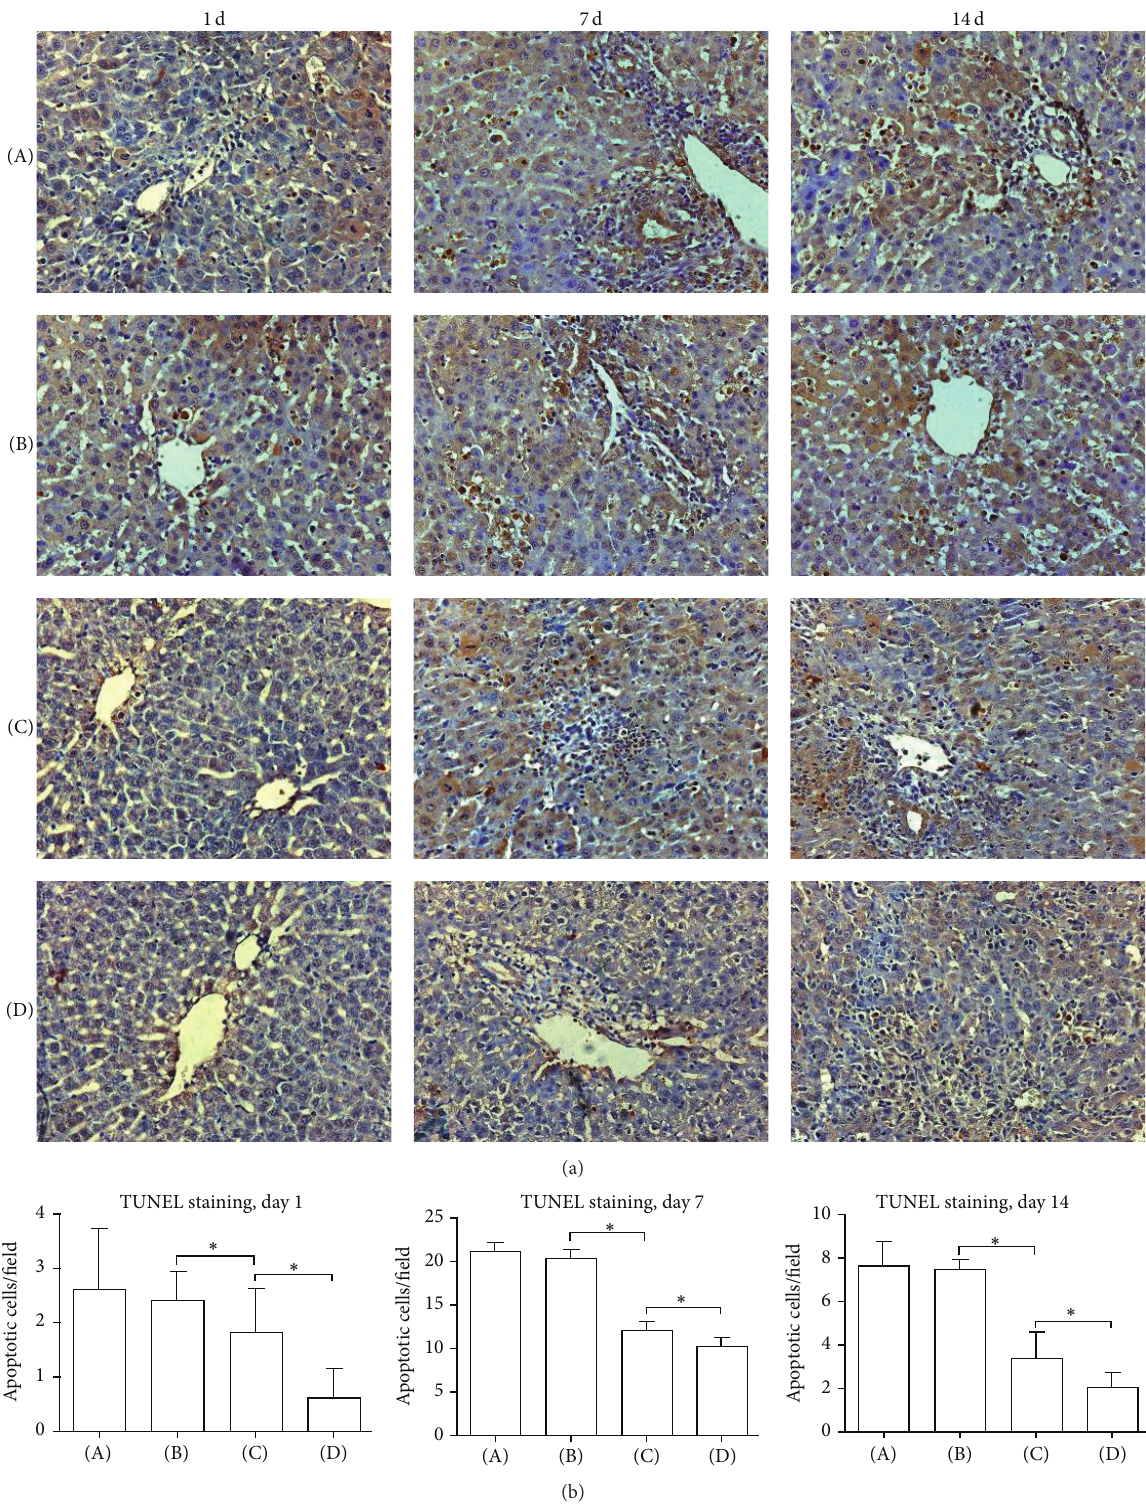
Figure 4: Apoptotic cells in liver grafts. (A) Normal saline group; (B) HO-1 group; (C) BMMSCs group; (D) HO-1/MSCs group. (a) Histological sections from rats of four groups at each time point were subjected to the TUNEL assay (200x). (b) Histogram showing the percentage of positive apoptotic signals in each group on days 1, 7, and 14. Apoptotic cell numbers in the HO-1/MSCs group were significantly lower compared with control groups on POD 1, 7, and 14, respectively ( ∗ 𝑃 < 0.05